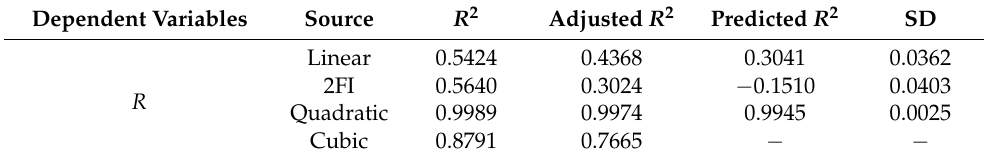
Table 3. Regression analysis and response regression equation results for the final proposed